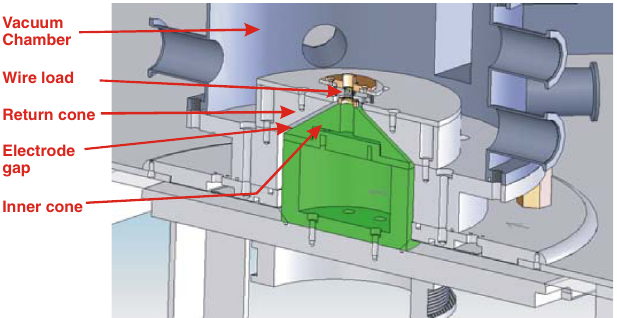
FIG. 2. CAD drawings of the completed conical power feed (inner cone in green and return structure in grey), showing wire array